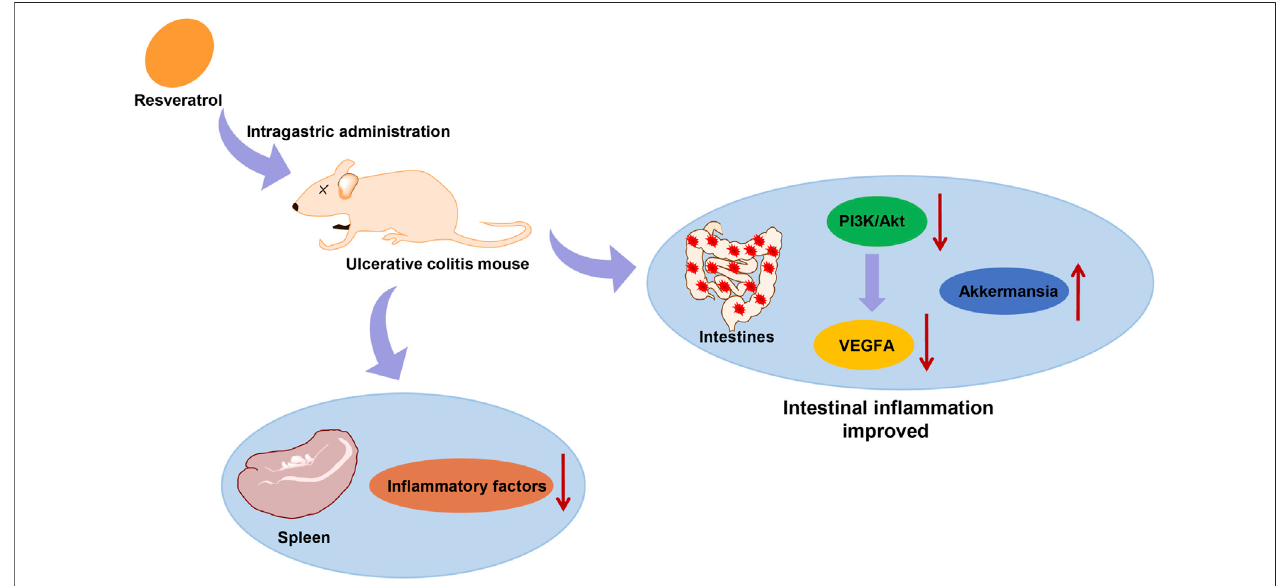
FIGURE 6 | RSV suppressed the activation of the PI3K/Akt pathway and reduced the VEGFA gene expression to alleviate UC.